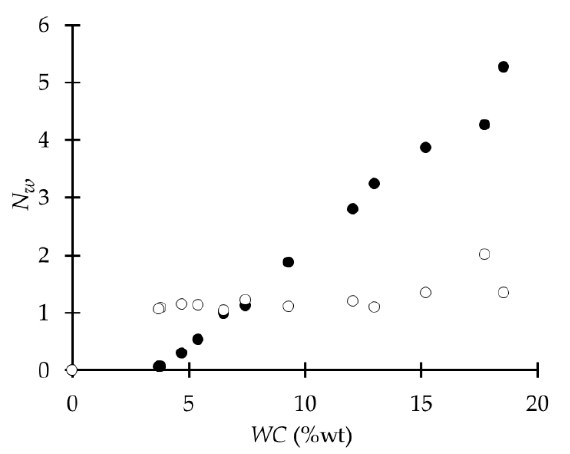
Figure 6. Example behavior of non-freezable water ( N wnf , o), and freezable water ( N wf , • ) in relation to water content ( WC ) of poly(DTH adipate).